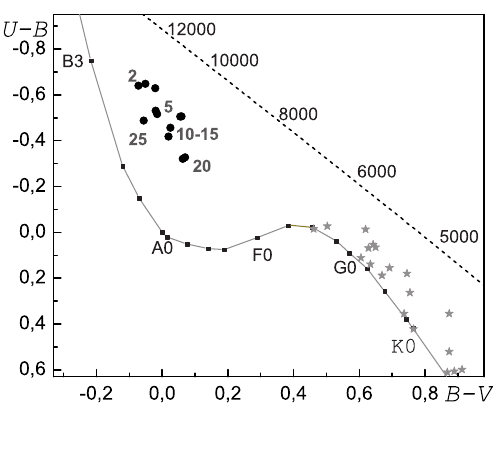
Figure 3: Two colour diagram. The average night magnitudes of V observations from Fig. 1 and our colour indices data are shown in Fig. 2. The evolution of the nova in a two colour ( U − B, B − V ) diagram is displayed in Fig. 3. The main and black body sequences are plotted with solid and dashed lines, respectively. The positions of field stars are marked by stars. Filled circles correspond to the positions of the dwarf nova at the days after maximum, which occurred at JD=2456403.